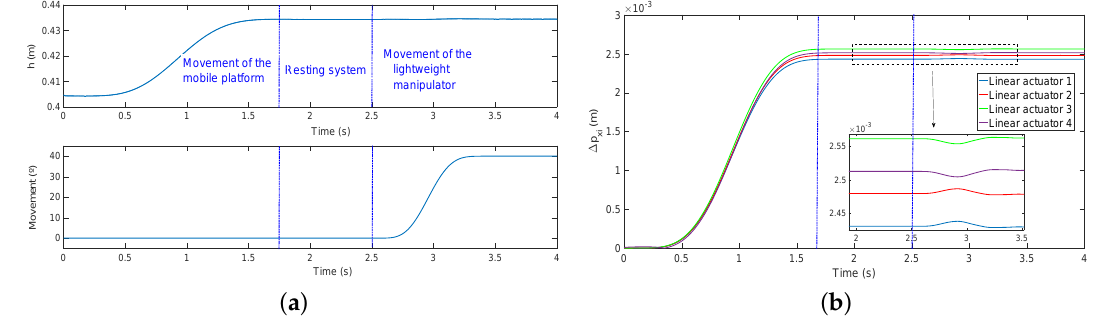
Figure 23. ( a ) top view of the platform; ( b ) front view of the